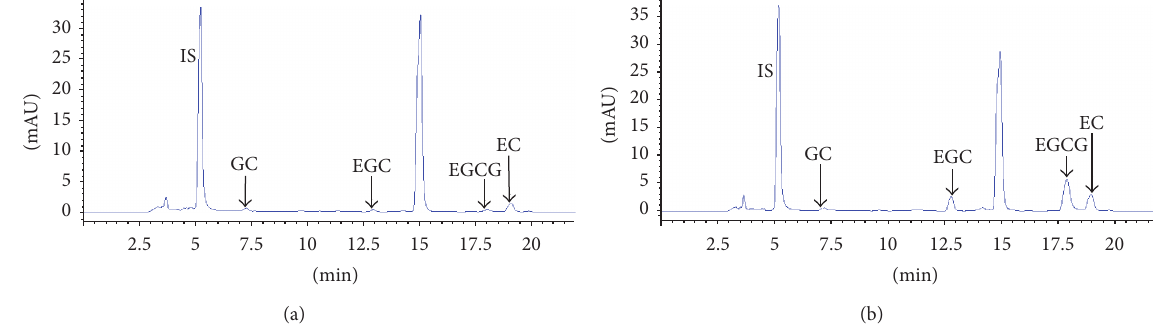
Figure5:Highperformanceliquidchromatographyspectraofgreenteapreparedwithdifferentwatersolutions.(a)Tapwaterand(b)distilled water (IS = gallic acid, GC = gallocatechin, EGC = (–)-epigallocatechin, EGCG = (–)-epigallocatechin gallate, and EC = (–)-epicatechin).